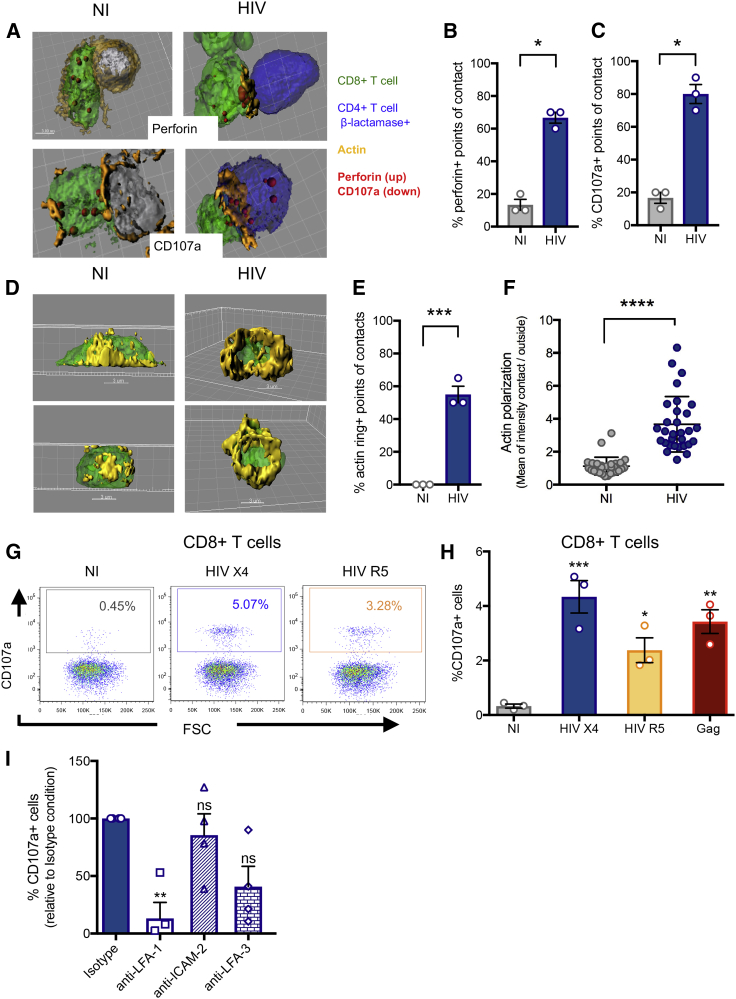
Recognition of HIV+ Non-activated CD4+ T Cells by Autologous HIV-Specific CD8+ T CellsTwo hours after a Vpr-βlam infection assay, the primary non-activated HIV+ CD4+ T cells (blue) from an elite controller (EC) were co-cultured for 30 min with an autologous Gag-specific CD8+ T cell line (green), fixed, and stained for actin with phalloidin (orange) and perforin (red) or CD107a (red), and cell contacts analyzed by confocal microscopy. A compilation of z stacks was acquired for each cell contact and analyzed with IMARIS software. NI, non-infected; HIV, HIV infected.(A) 3D reconstructions of two representative experiments with non-infected cells (left) or infected cells (right) are shown with perforin staining (top) or CD107a staining (bottom).(B and C) The percentage of points of contact displaying fluorescent signal for perforin (B) or CD107a (C) is quantitated and shown. Means ± SDs for three independent experiments using cells coming from three different HIV controllers are shown; statistics were calculated by unpaired t test. ∗p < 0.05.(D) For each cell contact, the actin signal was analyzed and quantified with IMARIS software in 3D. Two representative experiments are shown, demonstrating actin rings only in the HIV-infected condition.(E) The percentage of points of contact displaying actin rings is calculated for both conditions and shown as means ± SDs for three independent experiments with cells coming from three different HIV controllers. Statistics were calculated by unpaired t test.(F) Actin polarization on CD8+ T cells toward the point of contact was quantified by measuring the ratio of actin fluorescent signal at the point of contact versus the rest of the cell. The means ± SDs for three independent experiments with 10 cell contacts analyzed per experiment with cells coming from three different HIV controllers; statistics were calculated by unpaired t test.(G) CD107a staining gated on live CD3+CD8+ cells revealed the degranulation of CD8+ T cells in response to autologous HIV X4 infected cells (blue) or HIV R5 infected cells (yellow), compared to Gag peptide-sensitized target cells (red). A representative experiment is shown.(H) The means ± SDs for three independent experiments with cells coming from one HIV controller are represented. Statistics were calculated by an ANOVA multiple comparison test relative to the non-infected condition. ∗p < 0.05, ∗∗p < 0.01, and ∗∗∗p < 0.001.(I) Antibodies to LFA-I, ICAM-2, and LFA-3 were used in an experiment similar to (G) with HIV X4. The means ± SDs for four independent experiments with cells coming from four different HIV controllers are shown, and statistics were calculated with a one-way ANOVA multiple comparison test relative to the isotype control. ∗∗p < 0.01; ns, not statistically significant.See also Video S1 and Figures S3 and S4.